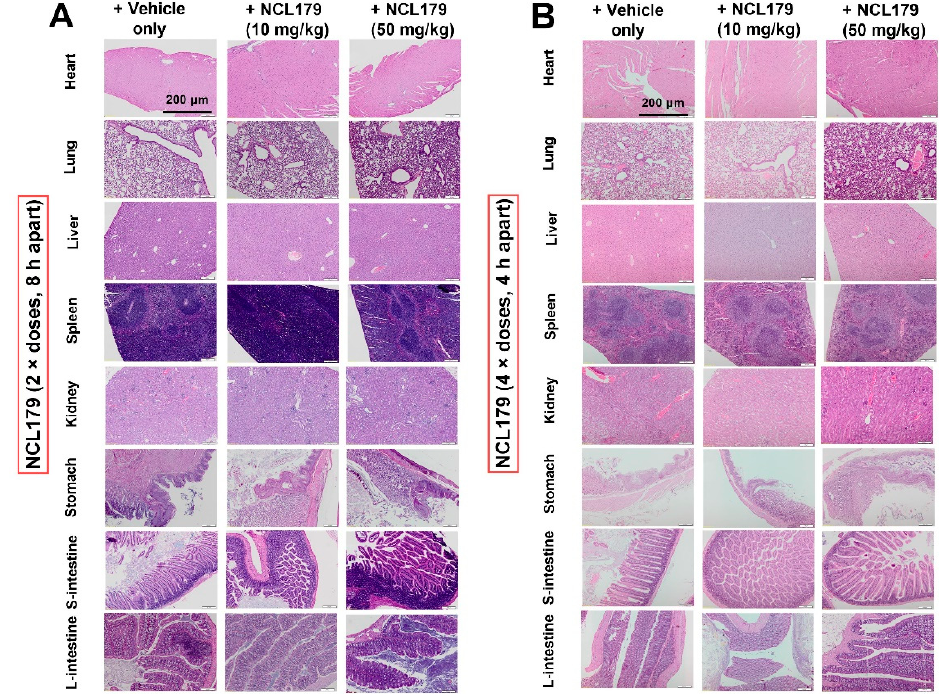
Figure 6. Representative histological images of heart, lung, liver, stomach, spleen, kidneys and small and large intestines from NCL179-treated and vehicle-treated mice. No histopathological changes were observed in mice treated orally with ( A ), 10 mg/kg, 50 mg/kg (2 × doses, 8 h apart), or ( B ), with 10 mg/kg, 50 mg/kg (4 × doses, 4 h apart) of NCL179 in comparison with vehicle. S-intestine, small intestine; L-intestine, large intestine. Scale bars: 200 µm